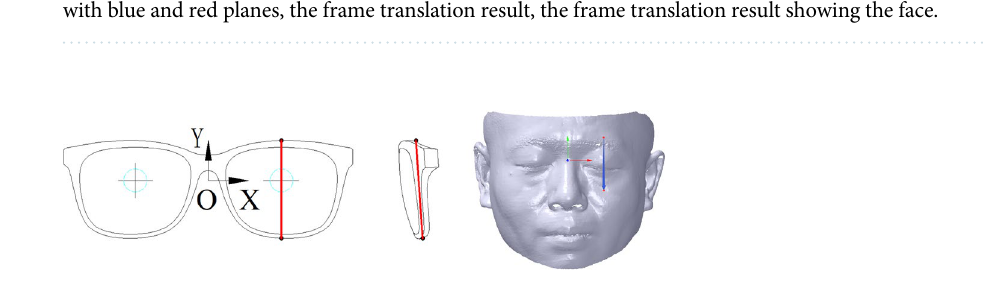
Figure 12. The dip line of the frame and the face. From left to right: frame,